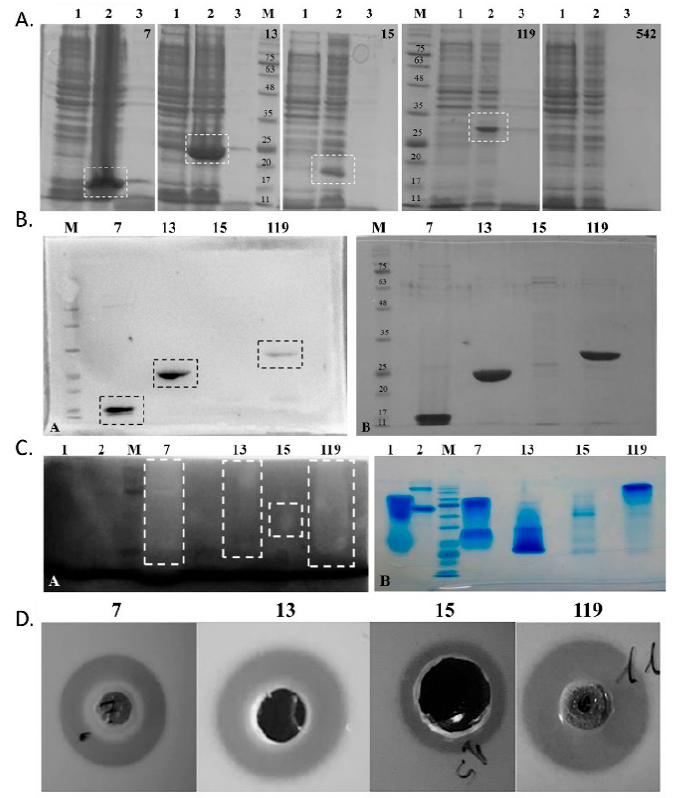
Figure 3. Overall assessment of purification and activity over peptidoglycan layer of phage lysins. Top right number depict phage endolysins from the left to right: 7—lysin Pa7 (expected molecular weight: 16.2 kDa); 13—lysin Pa13 (22.9 kDa); 15—lysin Pa15 (23.5 kDa); 119—lysin Pa119 (29.3 kDa); and 542 –lysin Pa542 (16.0 kDa); M—NZYColour Protein marker II (NZYTech, Lisbon, Portugal) with 75, 63, 48, 35, 25, 20, 17, and 11 kDa bands pointed out in ( A , B ). ( A ) SDS-PAGE of induction assays of the cloned lysins for (1) non-induced cells, (2) 3 h induced cells and (3) induced culture supernatants. Induced bands are highlighted (dotted box). ( B ) Western blot (left panel) and parallel SDS-PAGE (right panel) of the purified lysins. Identity of the produced recombinant proteins was confirmed by western-blot targeting (His) 6 -tagged proteins. Protein bands are highlighted (dotted boxes). ( C ) Zymogram using P. aeruginosa ATCC 27853 biomass (left panel) and parallel SDS-PAGE under zymogram conditions (right panel) of the purified lysins. Hydrolytic activity was detected as clear bands in the dark background (dotted boxes). ( D ) Halo-formation assays on M. luteus . Bacte- riolytic activity of the purified endolysins was qualitatively assessed against M. luteus in LB agar plates after small-scale kit purification. Positive bacteriolytic activity appears as a clear halo around the protein application as well. For each lysins, 30 µg were applied per well. A total volume of 75 µL was applied in the wells, except for Endolysin Pa15 for which a large well was needed and a 200 µL total volume was applied.